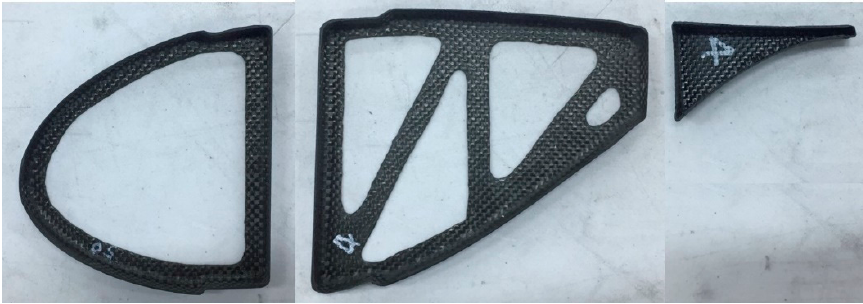
Figure 9. The truss ribs.